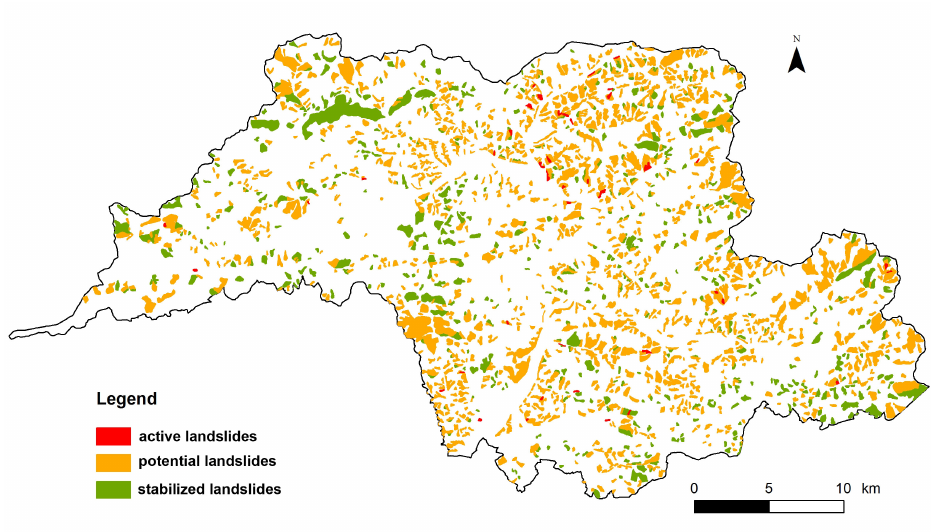
Figure 2. Landslide activity in the study